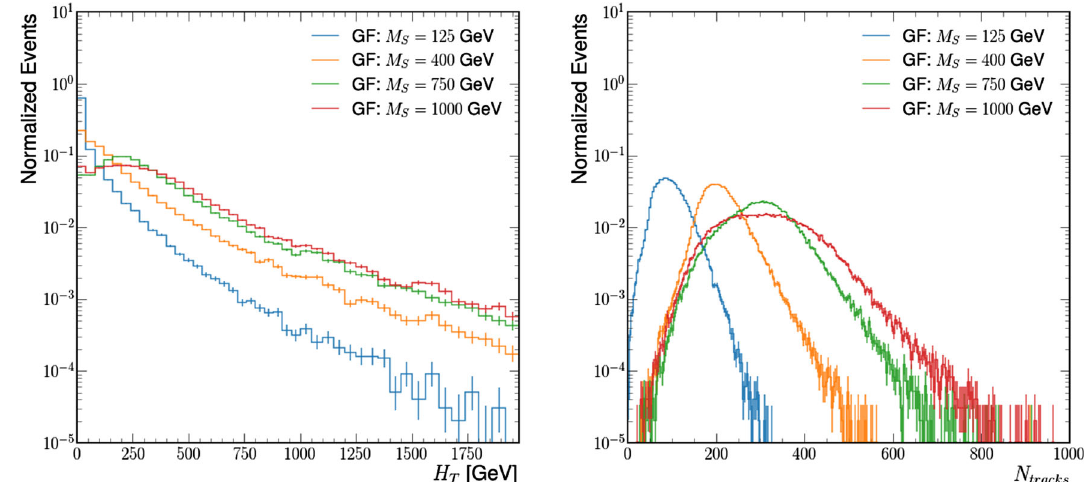
Fig. 18 The H T distribution for different SUEP mediator masses is shown on the left. The H T is calculated by taking the scalar sum of p T for generator level jets with p T > 20 GeV and | η | > 4 . 7. The number of tracks per event for different SUEP mediators is shown on the right.